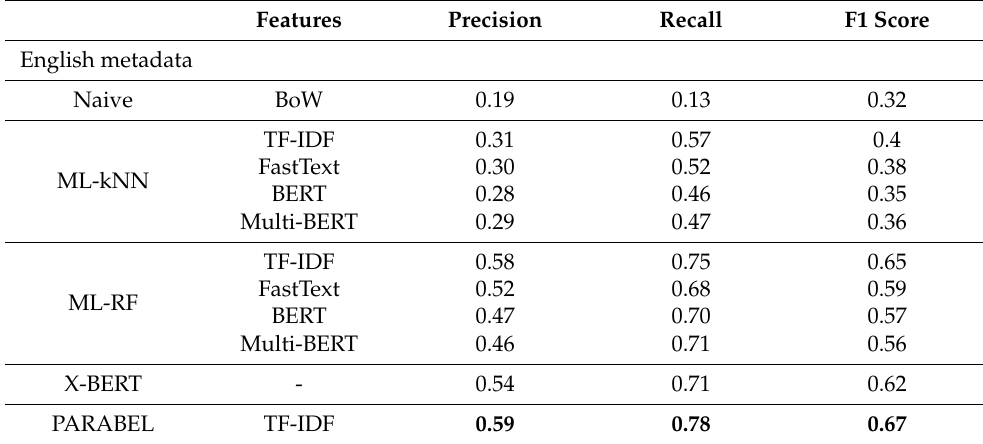
Table 3. Accuracy scores obtained from the evaluation of the models in the English and Finnish test